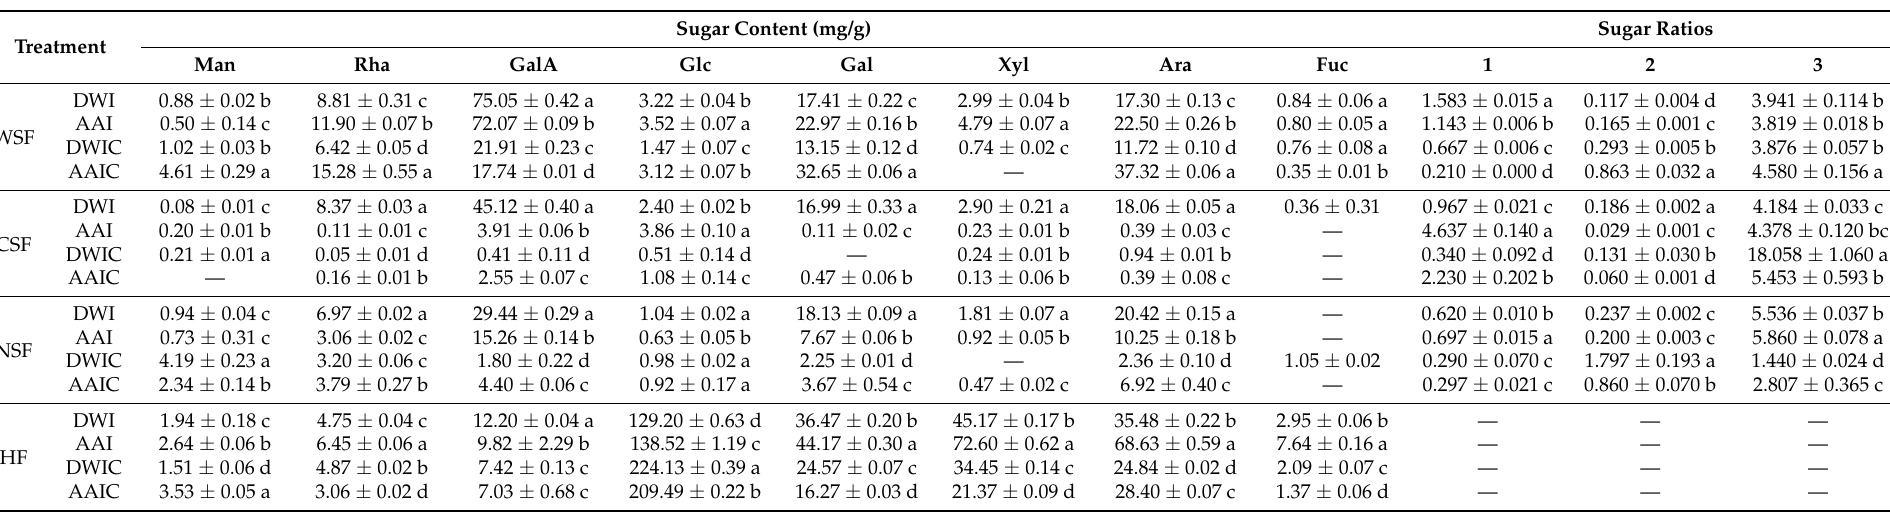
Table 1. Monosaccharide composition and sugar ratio (mol%) of cell wall fractions in different groups. Different letters of the same fraction represent significant differences in the same sub-column ( p < 0.05). Sugar ratios allow the gaining of information with reference to polysaccharide structure from sugar composition data. DWI: distilled water immersion for 15 h; AAI: 0.6% acetic acid immersion for 15 h; DWIC: cooked DWI; AAIC: cooked AAI; GalA: galacturonic acid; Rha, rhamnose; Gal: galactose; Man: mannose; Ara: arabinose; Glc: glucose; Fuc: fucose; Xyl: xylose. “—” indicates that the monosaccharide is not detected or the sugar ratio of the component is not